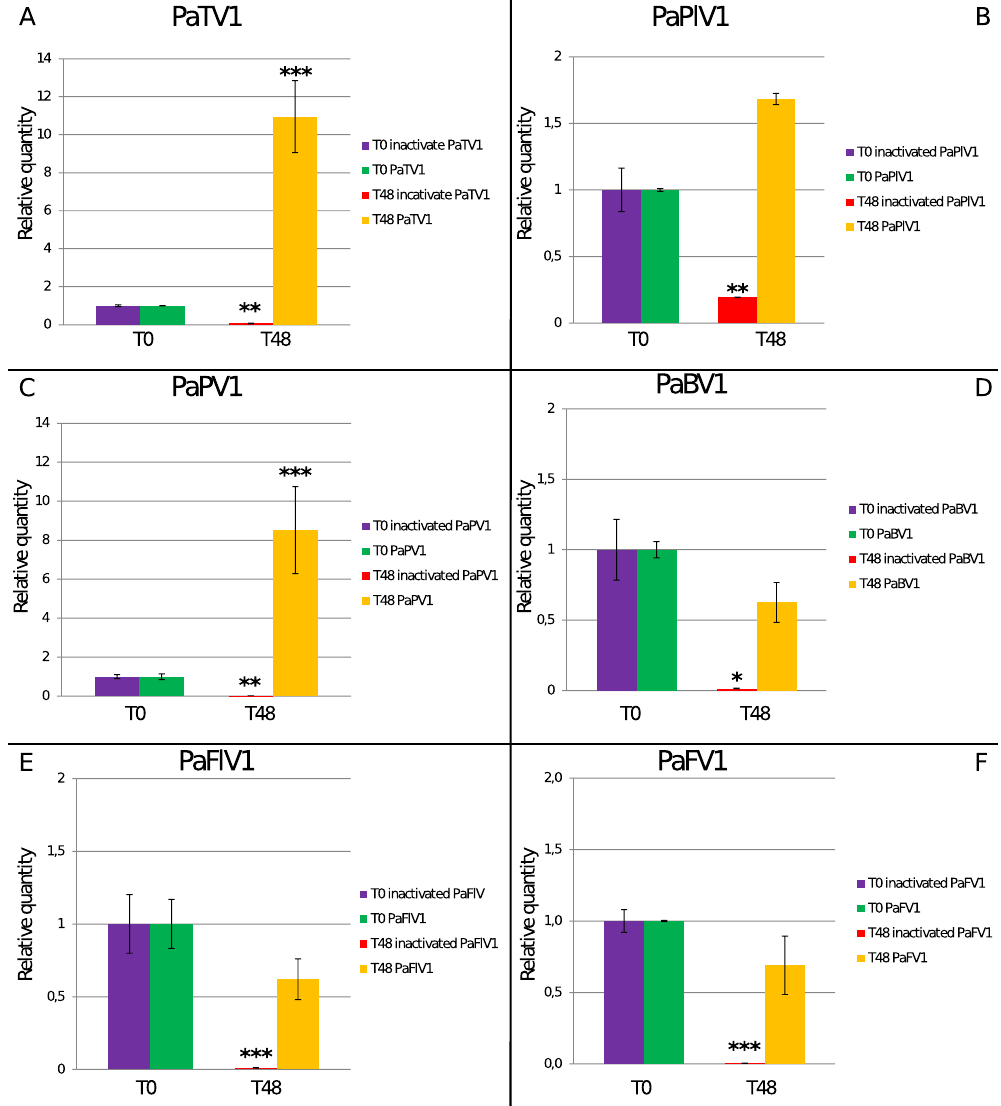
Figure 4. Comparison of virus accumulation in protoplasts of Nicotiana tabacum BY2 cells with filtered untreated or heat inactivated virus inocula. Quantitative Reverse transcriptase PCR (qRT-PCR) data from Nicotiana tabacum BY2 cells were used to obtain absolute quantification of viral RNA at T0 and T48 time points with heat-inactivated (purple for T0 and red for T48) or untreated (green for T0, yellow for T48) viral inocula. In Panel A: Quantification graph of PaTV1 confirmed the ability to replicate when the viral purification is untreated, whereas when inactivated before transfection the final RNA amount at T48 (red bar) was lower than at T0. In panels C quantification of the Partitivirus Penicillium aurantiogriseum partitivirus 1 (PaPV1): similarly to PaTV1, PaPV1 can replicate in untreated biological replicates whereas the RNA accumulation level decreased when thermally inactivated suspension was used for transfection. Panels B,D,E and F show data for the other viruses: none of them displays a statistically significant increase in virus RNA load. * P < 0.05 ** P < 0.01 and *** P <